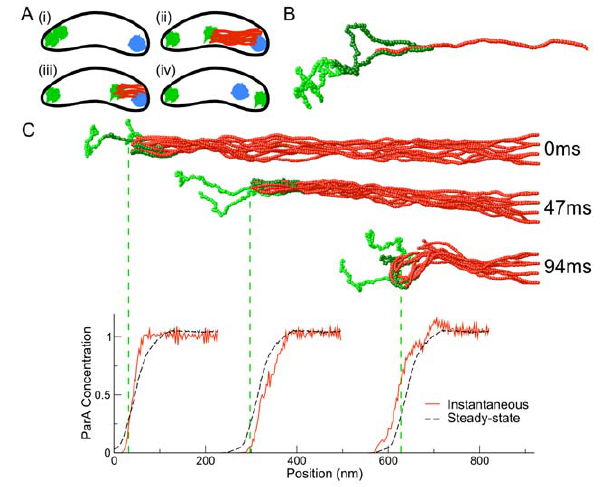
Figure 1. Schematic model for chromosome segregation and simulation snapshots. (A) Model of chromosome segregation in Caulobacter crescentus . ( i ) Initially, the two copies of the origin of replication ( ori - green) and the terminus ( ter - blue) of the chromosome are localized at the stalked and swarmer poles, respectively. ( ii ) The two origins separate and a structure of ParA protein (red) emanating from the swarmer pole comes into contact with the medial origin; ParB, polymerized on the chromosome near the origin, binds to ParA. ( iii ) ParB and the origin localize with the end of the ParA and move across the cell as ParA depolymerizes. ( iv ) The origin localizes near the swarmer pole; the terminus moves towards mid-cell. (B) Snapshot of ParB-ParA binding in simulation. The central strip of the ParB polymer (dark green) binds side-on to ParA filaments, whereas the peripheral segments of the ParB polymer (light green) cannot bind to ParA. (C) Snapshots of the full simulation and corresponding ParA filament concentration profiles (red). The dashed green lines indicate the center of mass of the ParB polymer. ParB binds to ParA and disassembles the ParA bundle (for clarity, depolymerized ParA monomers are not displayed). This interaction creates a steady-state ParA filament concentration gradient (black), which moves with and transports the ParB across the cell, providing a mechanism for chromosome segregation.